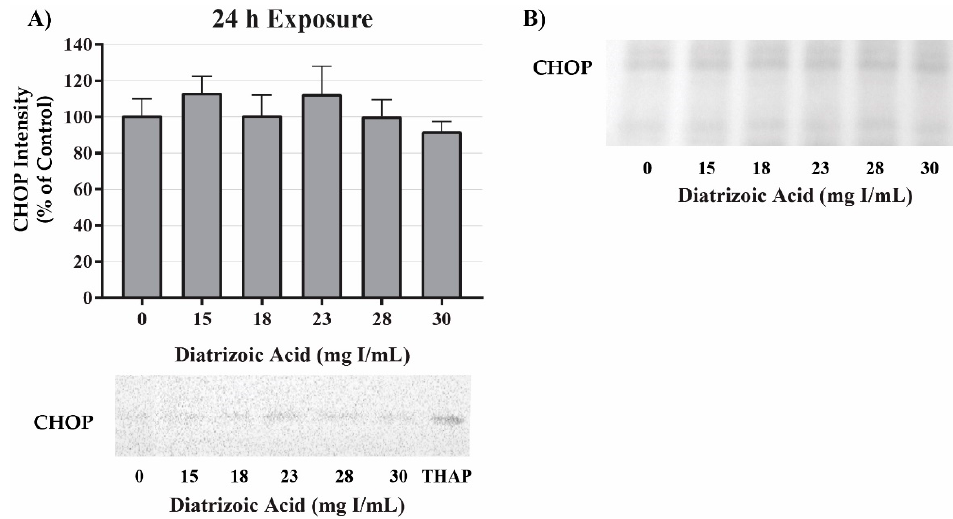
Figure 10. Diatrizoic acid effects on C/EBP homologous protein (CHOP) expression in HK-2 cells. DA did not induce ER stress. Representative blots and cumulative densitometry included for CHOP expression at 24 h ( A ). Panel ( B ) depicts Memcode reversible stain for 40 µg loaded protein. Positive control for CHOP expression was thapsigargin (THAP). Values represent mean ± SEM for three independent experiments.